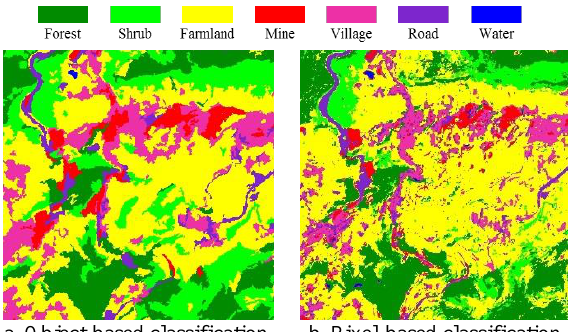
Figure 6. Comparison of local classification result between object-based and pixel-based